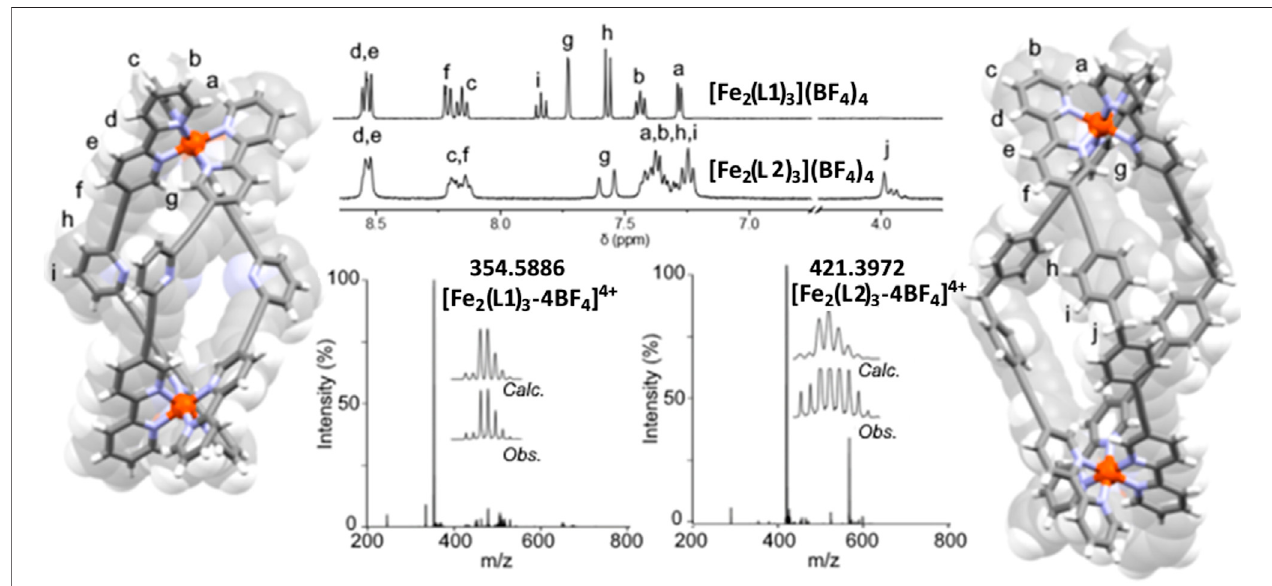
FIGURE 2 | X-ray structures showing the overlaid stick and space fi ll representations of [Fe 2 ( L1 ) 3 ](BF 4 ) 4 and [Fe 2 ( L2 ) 3 ](BF 4 ) 4 with related partial 1 H NMR spectra (500 MHz, CD 3 CN, 298 K) and associated ESI-mass spectra. Fe-Fe distances; [Fe 2 ( L1 ) 3 ](BF 4 ) 4 (cid:1) 14.2 Å, [Fe 2 ( L2 ) 3 ](BF 4 ) 4 (cid:1) 19.1 Å. Solvent molecules and counter anions were omitted for